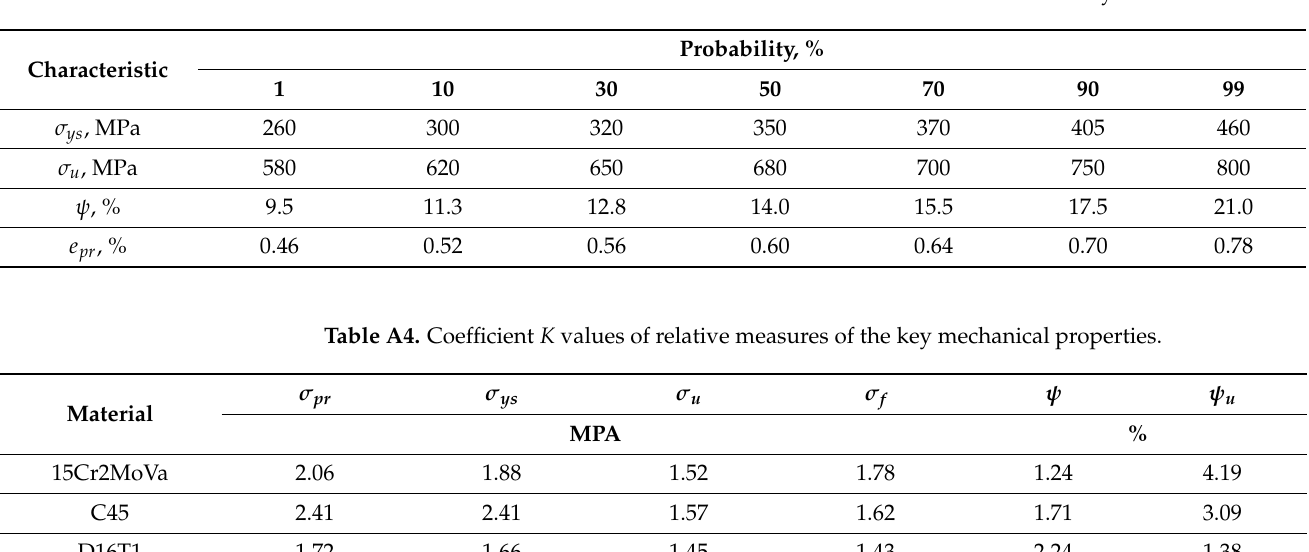
Table A3. Probabilistic values of mechanical characteristics for aluminium alloy D16T1.